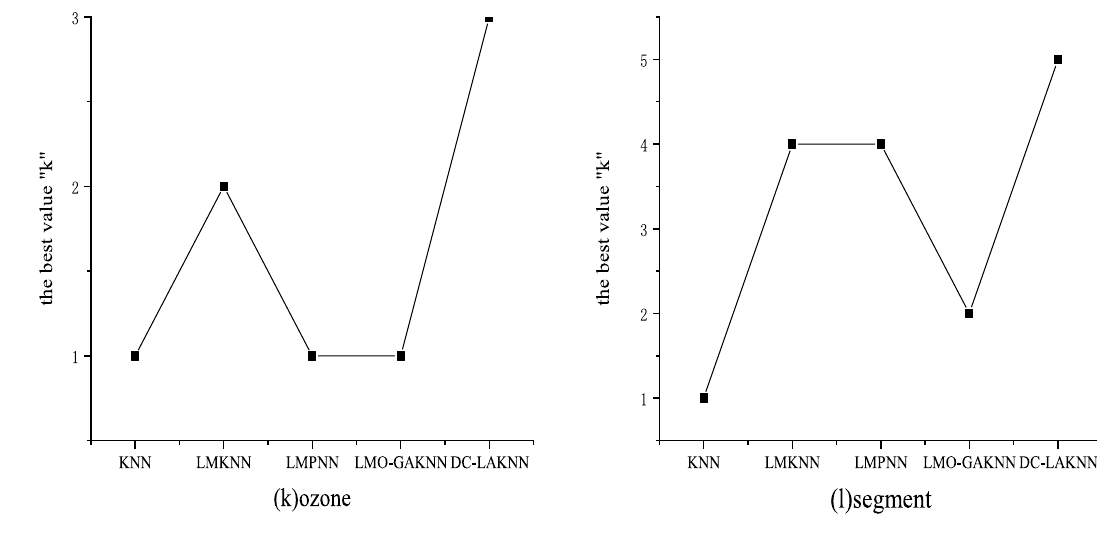
Fig. 1 The best value k of each method on different